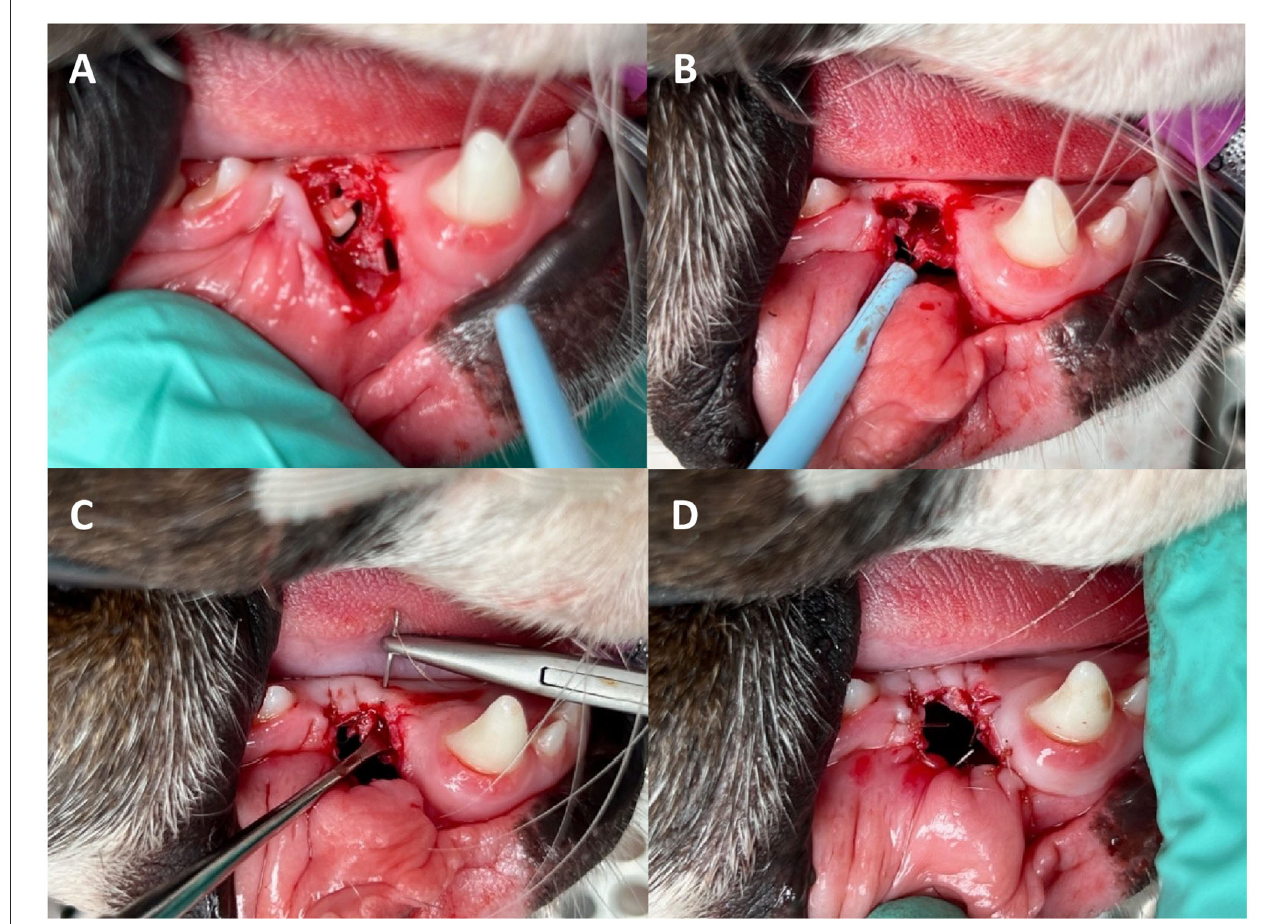
FIGURE1 Marsupialisation of a dentigerous cyst at the level of an unerupted right mandibular first premolar tooth. (A) Creation of a triangle mucoperiosteal flap to expose the unerupted mandibular 1st premolar tooth and the cyst lining. (B) Unerupted tooth was extracted and the cyst lining separated from the alveolar bone. (C) Suturing the gingiva to the cyst lining. (D) Final marsupialisation.